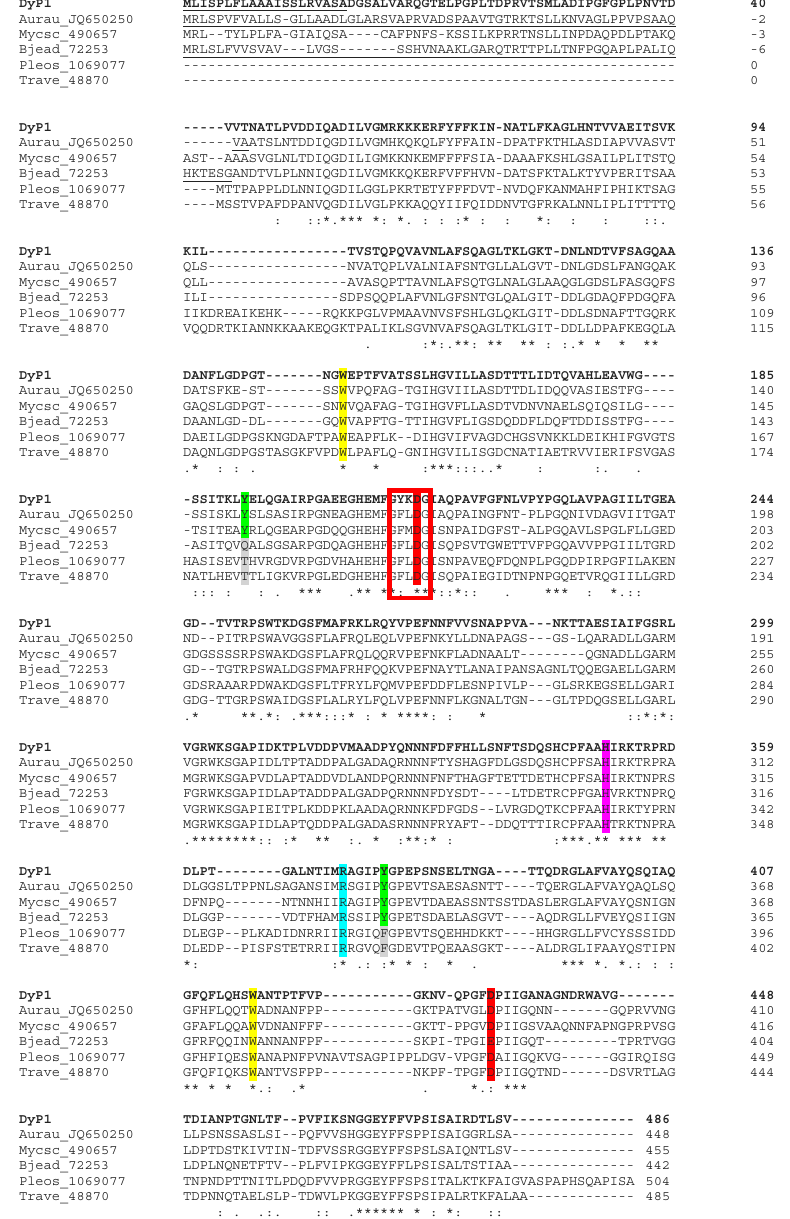
Figure 3. Alignment of DyP1 and five characterized DyPs from Cluster I (Aurau_JQ650250, Mycsc_490657, and Bjead_72253) and III (Pleos_1069077 and Trave_48870). Highlighted residues include (i) proximal histidine (magenta) and aspartate (red); (ii) distal-side arginine (cyan) and aspartate (red), the latter within the GXXDG signature motif (red box); and (iii) four solvent-exposed aromatic residues, corresponding to two conserved tryptophans (yellow), as well as two tyrosines (green) sometimes substituted by other amino acids (gray). Alignment was produced with Clustal2.1, and symbols below the sequences indicate full conservation of the same (asterisk) or equivalent residues (colon) and partial residue conservation (dot).